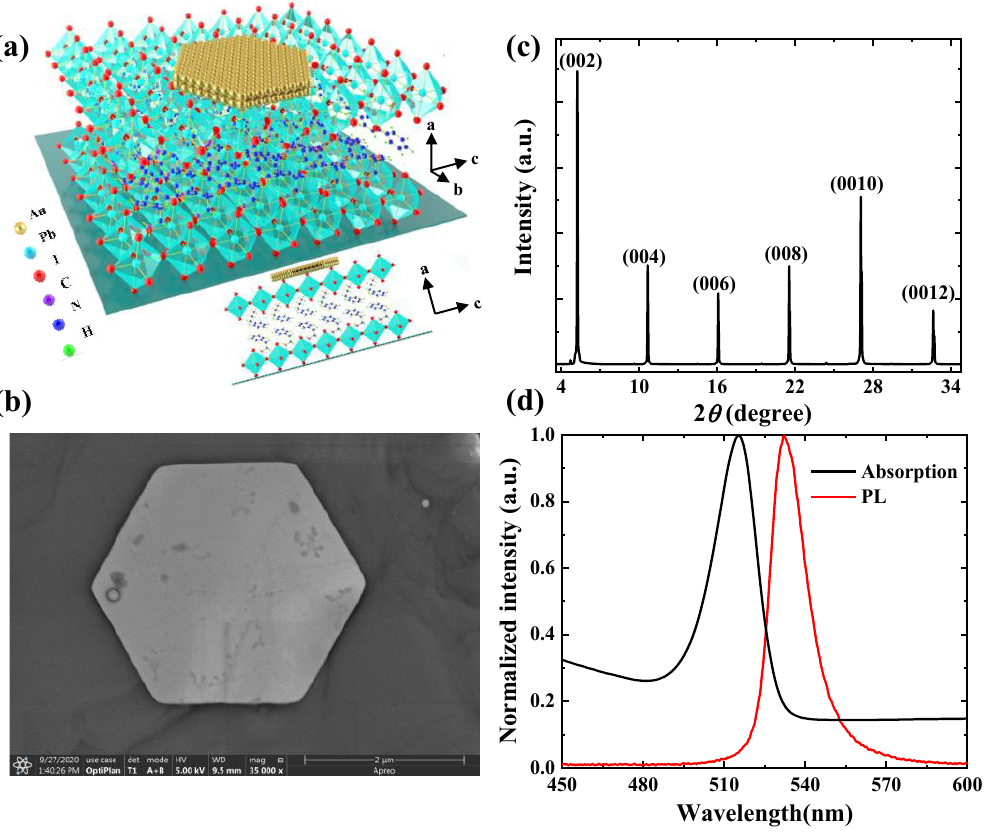
Figure 1: Spectroscopic characterization of (PEA) 2 PbI 4 perovskite fi lms. (a) Schematic diagram of sample configuration where Au NPLs were deposited on surface of perovskites for the generation of coherent acousticphonons.Theperovskitefilmwasspin-coatedonglasssubstrate.(b)SEMimageofanareaofperovskitefilmwithaAuNPLontop.(c) XRD spectrum, and (d) UV – Vis absorption (black line) and photoluminescence (red line) spectra of the perovskite